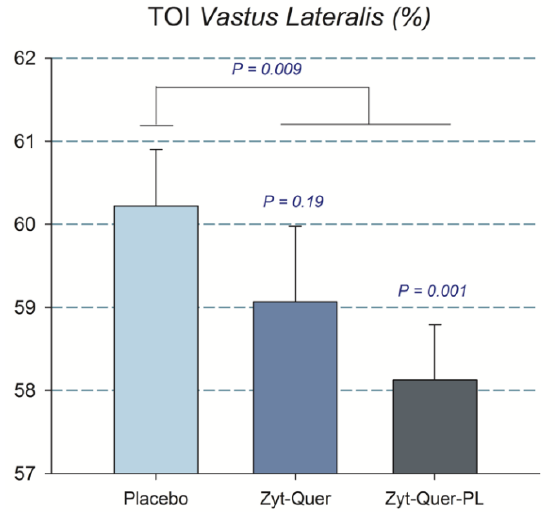
Figure 5. Tissue oxygenation index of the musculus Vastus Lateralis during the 60 s ischemia applied at the end of the third Wingate test. The bars correspond to the mean values after the ingestion of placebo, Zynamite ® (Zyt) combined with quercetin (Quer) o Zynamite ® combined with quercetin and phospholipids (PL). Error bars represent the standard error of the mean. p values: comparison with placebo. N = 40.